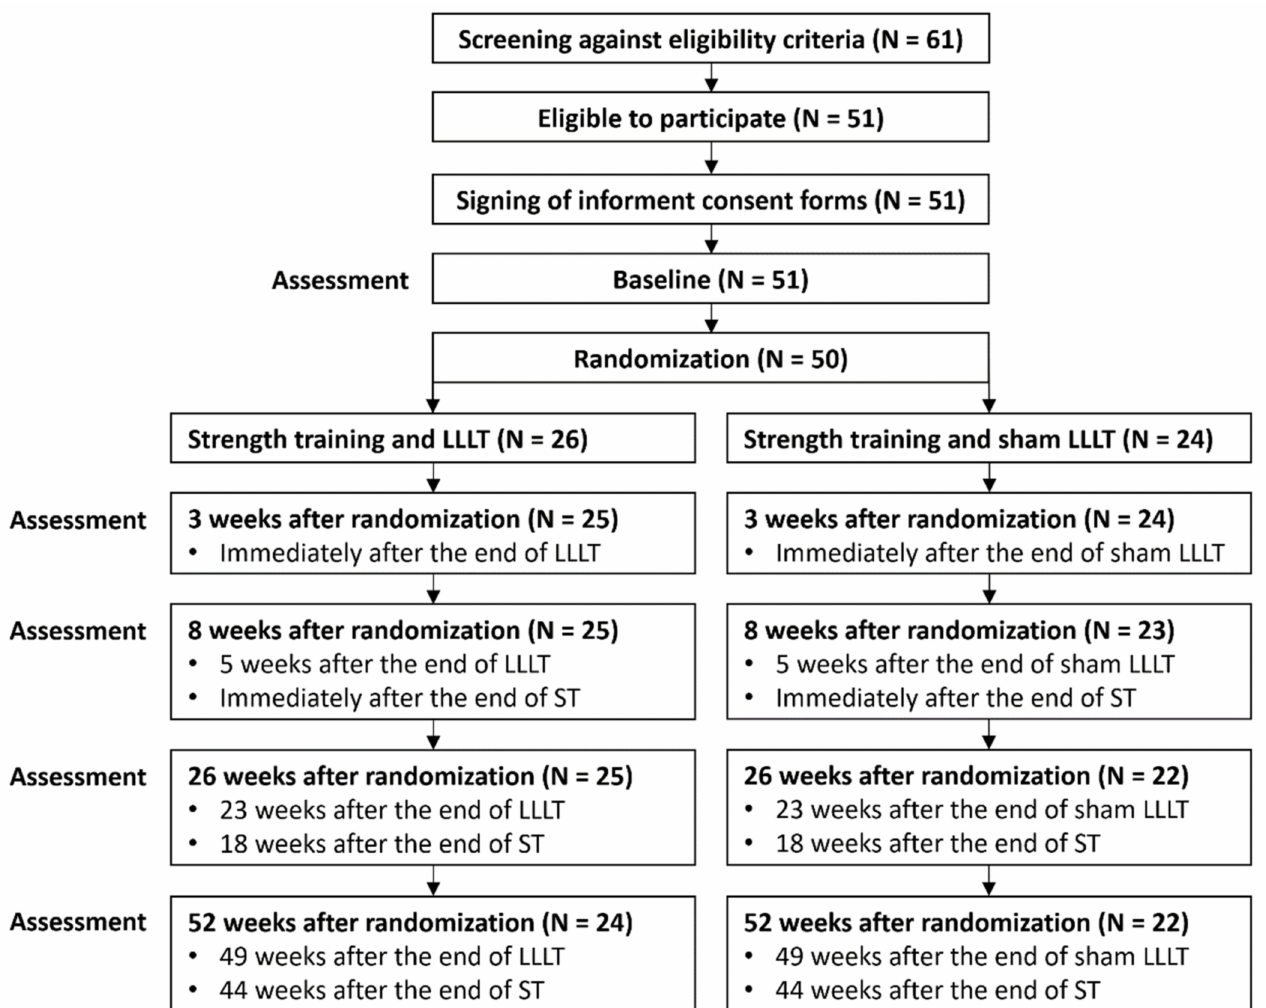
Figure 1. Study flowchart. Abbreviations: LLLT: low-level laser therapy; ST: strength